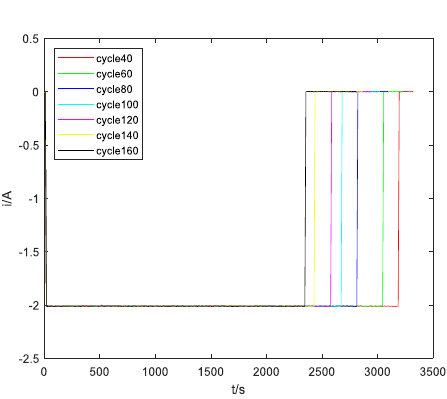
Figure 3. Output current